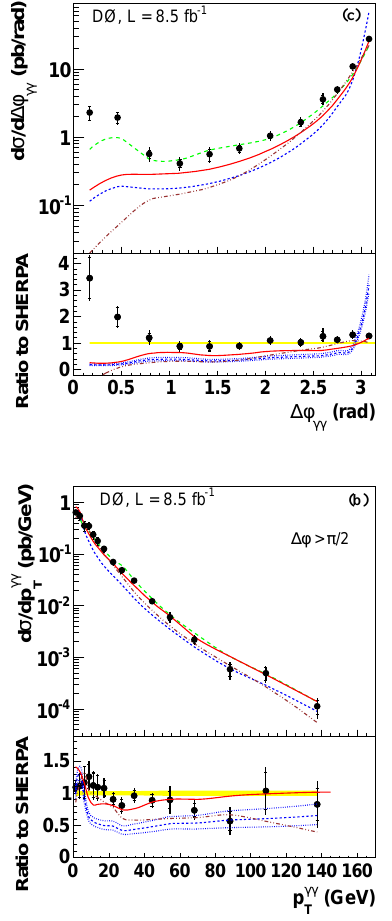
Figure 6. The di ff erential diphoton cross section as a function of invariant diphoton mass , M γγ (Upper) and transverse momentum of the diphoton system p γγ (Lower) along with the predictions T from DIPHOX, RESBOS , 2 γ NNLO , and